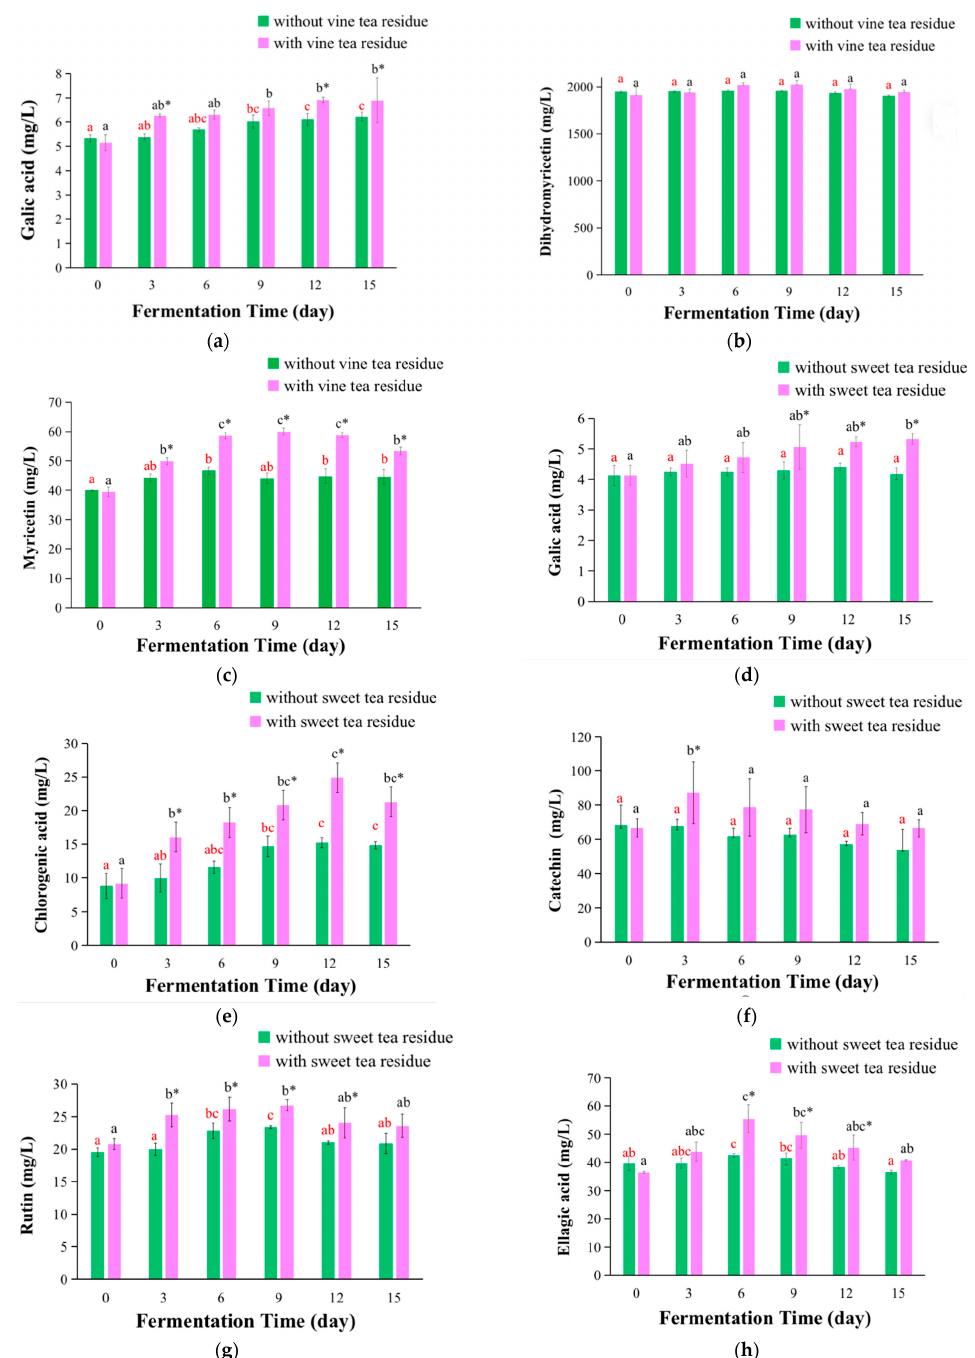
Figure 6. The changes of concentrations of components of kombucha produced by fermentation with or without tea residues at different fermentation time. ( a – c ) kombucha from vine tea, and ( d – h ) kombucha from sweet tea. The different red letters indicated that kombucha fermentation with- out tea residues at different fermentation time were significant differences ( p < 0.05), and the same red letter indicated no significant difference ( p > 0.05). The different black letters indicated that kombucha fermentation with tea residues at different fermentation time had significant differences ( p < 0.05), and the same black letter indicated no significant difference ( p > 0.05). * Indicated that there was a significant difference between the kombucha fermentation with tea residues and kombucha fermentation without tea residues at the same fermentation time ( p < 0.05).